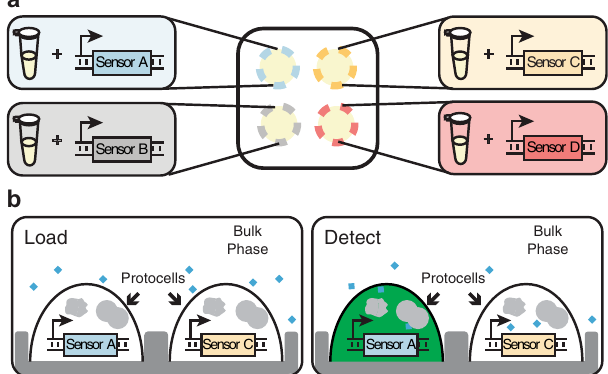
Fig. 1 Schematic of the membrane-less protocell array platform for simultaneous detection of multiple analytes. The use of a spatially patterned array of phase-separated protocell sensors enables each microwell to provide measurements for multiple analytes using a single fl uorescent or colorimetric reporter. a An overhead view of a microwell with four micro- basins. White area surrounding the micro-basins (yellow-shaded regions) represents the bulk phase formed by a PEG solution containing the analytes to be detected. Each micro-basin has a protocell containing a CFE reaction (represented by the microcentrifuge tube) with a different sensor plasmid or genetic circuit. b Side view of a microwell with micro-basins. Analytes in the bulk phase (blue diamonds) enter protocells to activate their cognate sensor (blue DNA construct), producing detectable reporter signals. Multiple analytes can be measured in parallel by tracking which protocell produces reporter signals (green color on the